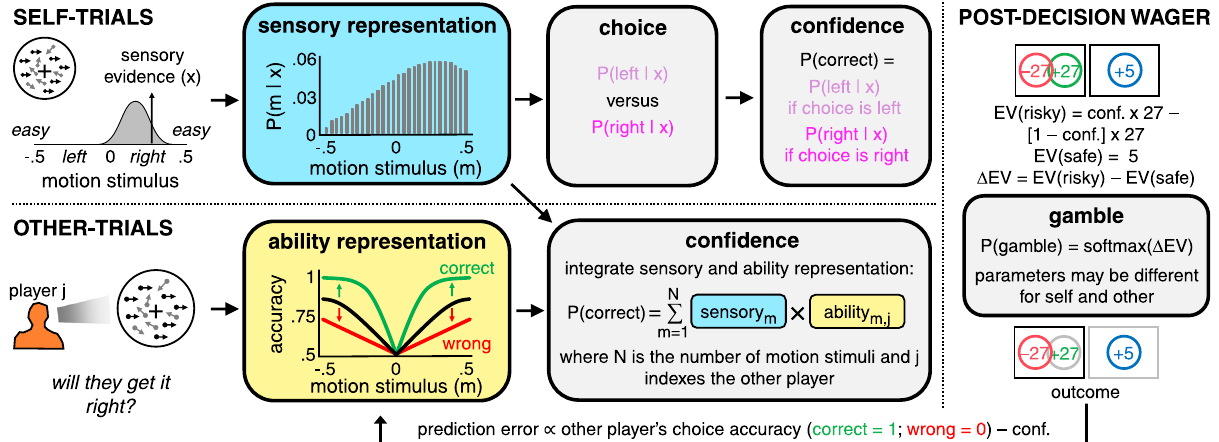
Fig. 3 Illustration of a con fi dence computation for self and others under the ToM-model. All models assumed that participants ’ choices and con fi dence were computed on self-trials according to Bayesian decision theory. Participants represent the stimulus space as comprised of a set of distinct motion stimuli, each de fi ned by a direction (sign) and a coherence (absolute value). On each trial, participants receive sensory evidence sampled from a Gaussian distribution whose mean is given by the true motion stimulus and whose standard deviation is given by a participant ’ s sensory noise. Participants compute a belief state over the stimulus space given the sensory evidence and their sensory noise (blue box) and use this belief state to generate both a decision about the motion direction and their con fi dence in this decision being correct. The ToM-model assumes that participants compute con fi dence in others ’ choices by combining their belief state over stimulus space with a representation of another player ’ s expected accuracy for each motion stimulus (yellow box). The latter representation – in effect, a psychometric function – is derived from an estimate of the other player ’ s sensory noise. This estimate is updated at the end of each trial using a Rescorla-Wagner learning rule that takes into account the accuracy of the other player ’ s choice and the con fi dence in this choice being correct. As a result of this update, the psychometric function becomes steeper after a correct choice (green) and shallower after an incorrect choice (red). On both trial types, con fi dence is used to calculate the difference in expected value between the risky and the safe options. Finally, the difference in expected value is entered into a softmax function to obtain the probability of selecting the risky option. The softmax parameters were allowed to vary between self- and